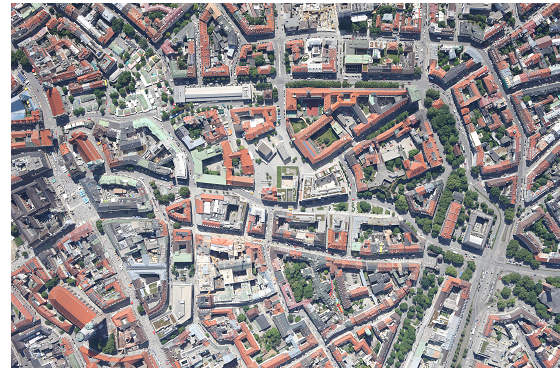
Figure 5. Example of an aerial image of the inner city of Munich.